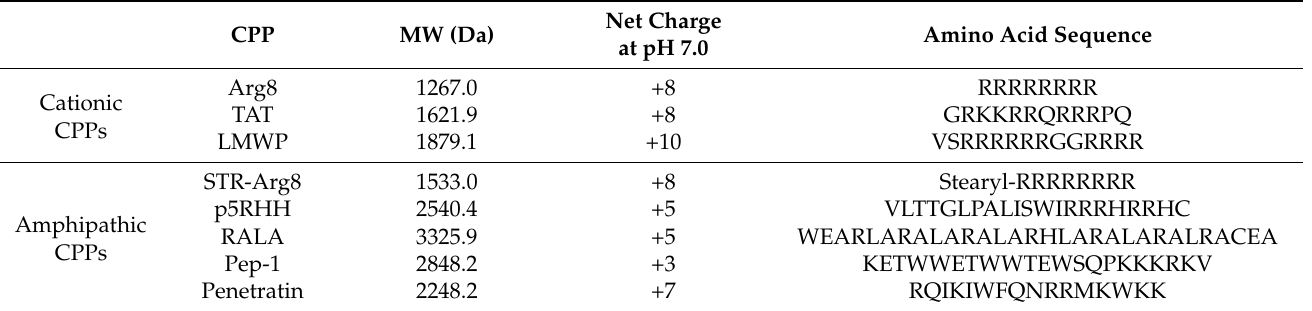
Table 1. Amino acid sequence, molecular weight and net charge (at pH 7.0) of cationic and amphi- pathic